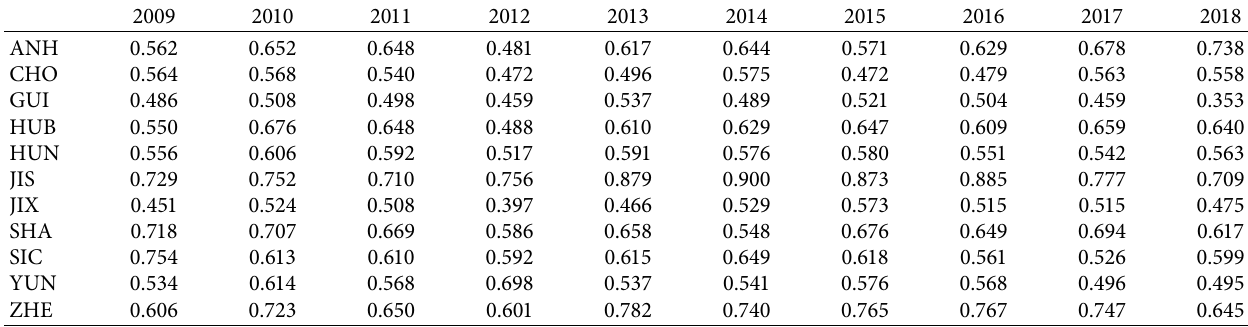
Table 6: CCD of the finance-air environment